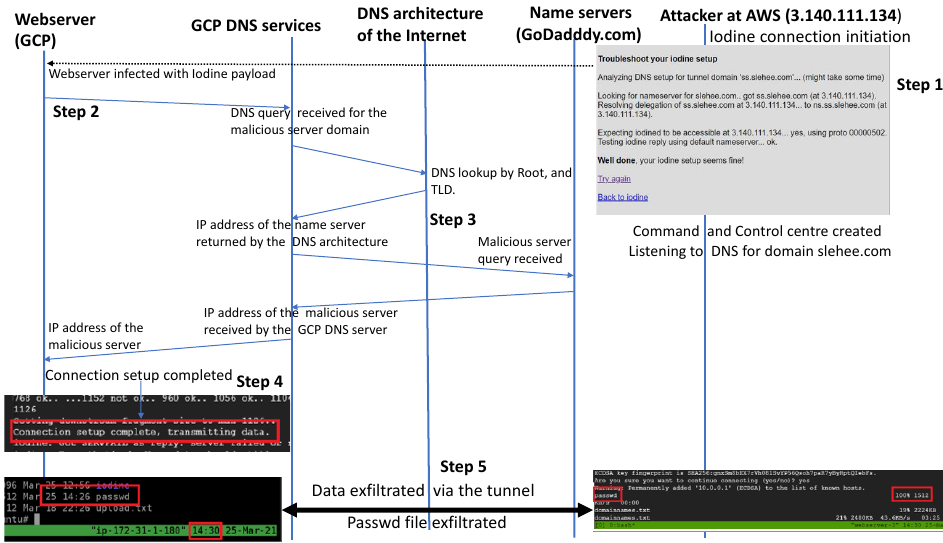
Figure 3. Sequence diagram showing DNS tunnel initiation and data